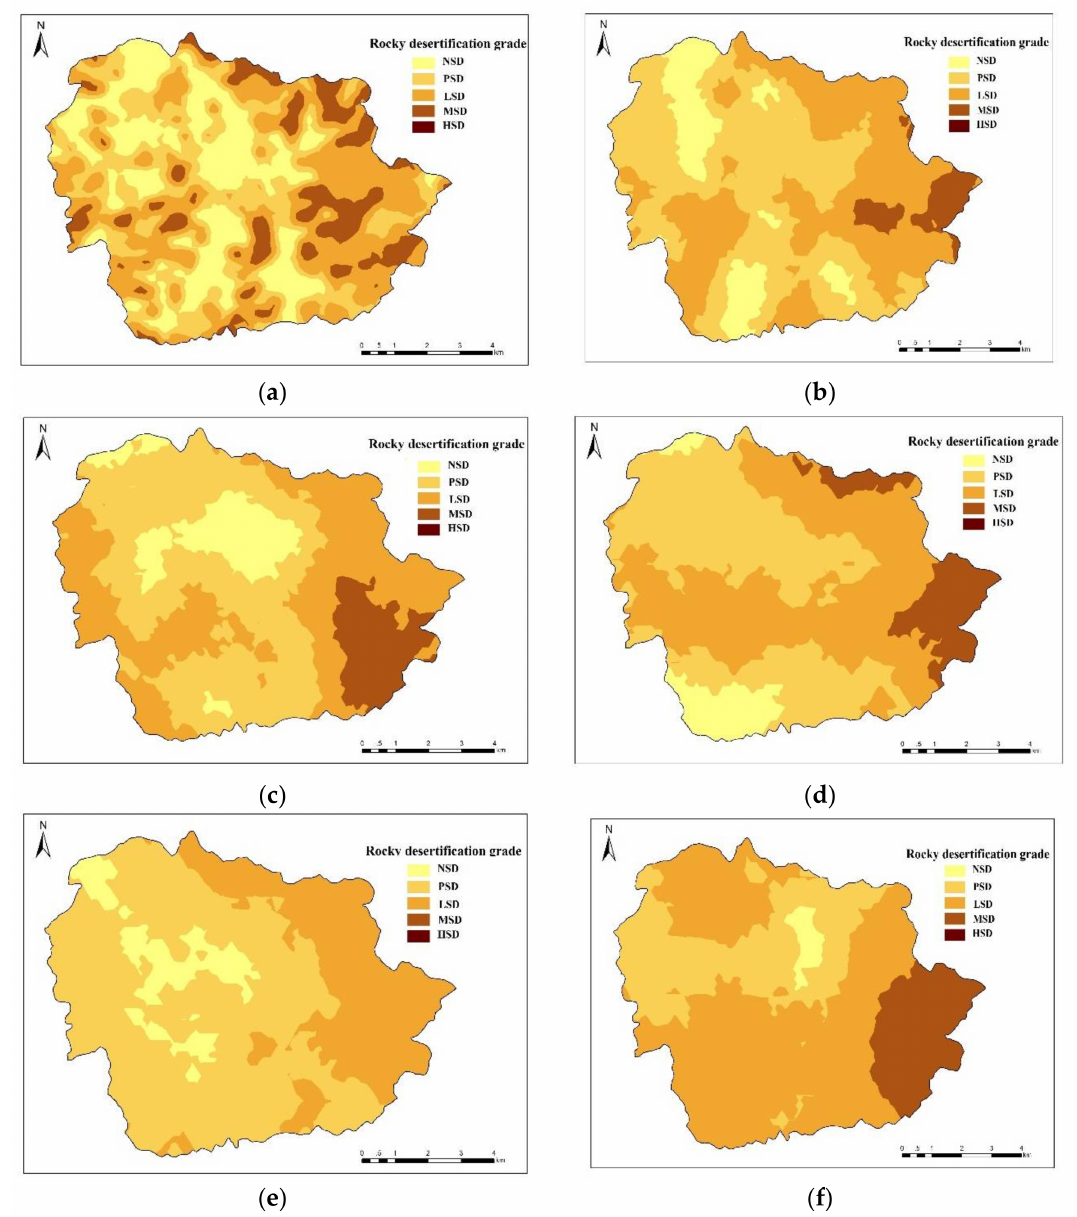
Figure 3. Spatial distribution of rocky desertification under different sampling scales: ( a ) 150 m × 150 m sampling scale; ( b ) 300 m × 300 m sampling scale; ( c ) 450 m × 450 m sampling scale; ( d ) 600 m × 600 m sampling scale; ( e ) 750 m × 750 m sampling scale; ( f ) 900 m × 900 m sampling scale. NSD is non-karst region; PSD is potential rocky desertification; LSD is slight rocky desertification;